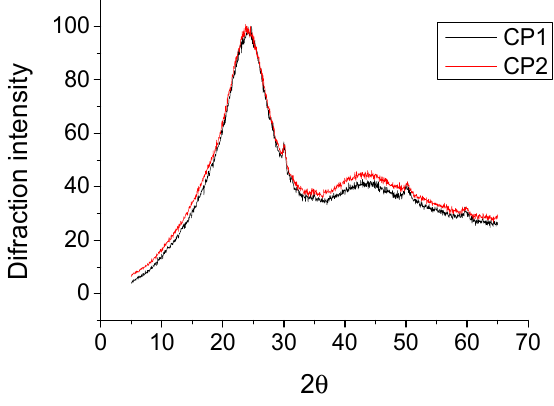
Figure 1. Powder X-ray scattering of CP1 and CP2 .